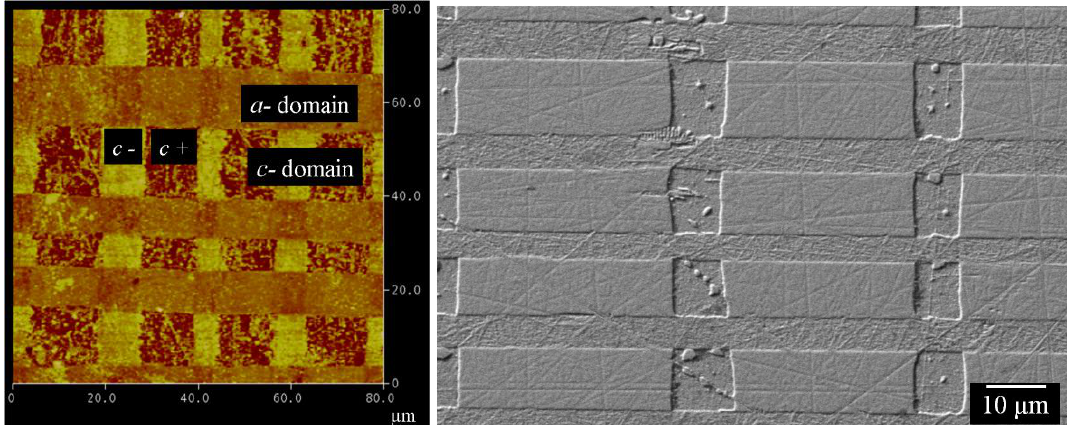
Figure 7. Barium Titanate single crystal etched with HF observed under (a) AFM (80 × 80 µm 2 region) and (b) a similar region observed by SEM. Note: these images have slightly different scales